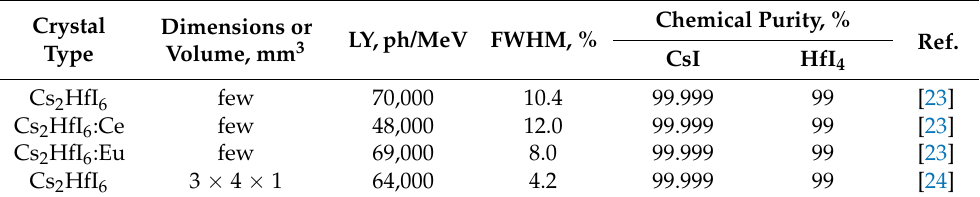
Table 4. List of Cs 2 HfI 6 crystals produced by different groups, crystal dimensions (or volume) used for characterization, the relative light yield (LY) and energy resolution (FWHM) measured under irradiation by 662 keV gamma line of 137 Cs source, and chemical purity of corresponding raw materials used for crystal